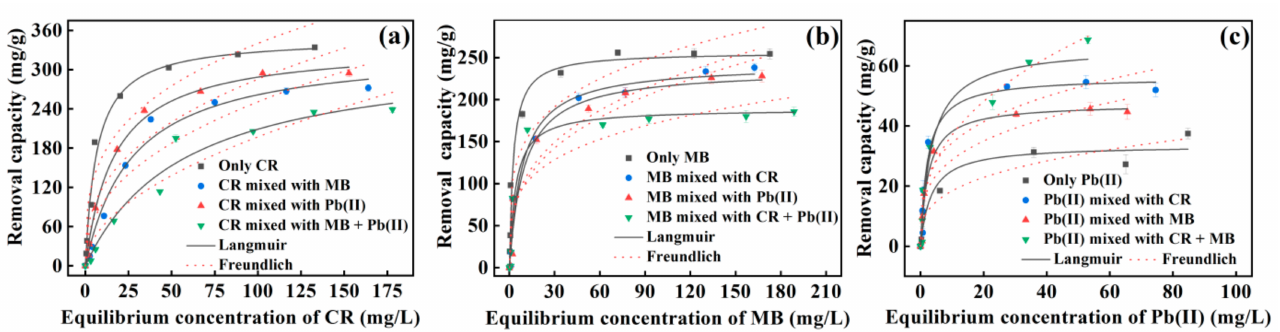
Figure 6. Adsorption isotherms of CR ( a ), MB ( b ) and Pb(II) ( c ) by the HC–MgAlLDH nanocomposite in the binary and ternary systems at pH 5.0, contact time 12 h, initial concentrations 10–300 mg/L for CR or MB and 1–100 mg/L for